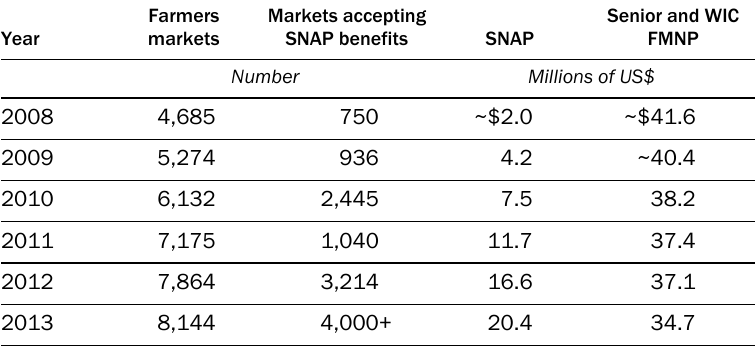
Table 2. Number of Farmers Markets and Redemption of Federal Nutrition Benefits in Farmers Markets: U.S.,